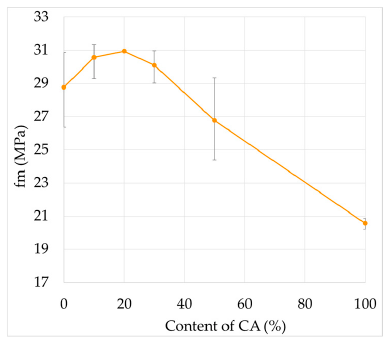
Figure 5. Compressive strength of the RCM at 90 days of age.